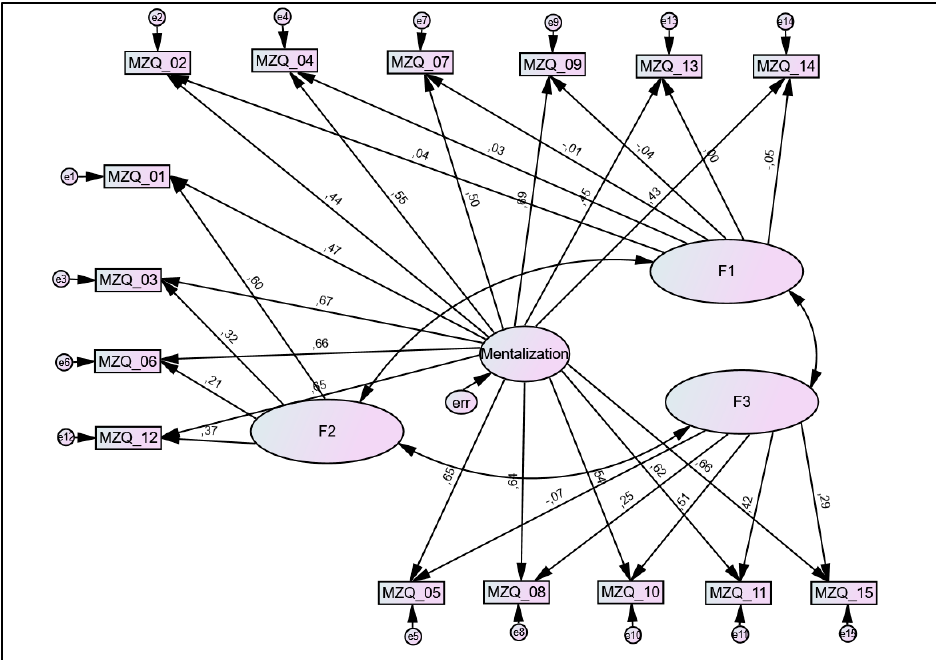
Figure 3. Bi-factor model for the Mentalization Questionnaire (MZQ) with a general factor and three subscales. Large circles represent proposed factors, rectangles represent items (with corresponding item number), and small circles represent error terms (e). Numbers next to arrows in the model represent standardized estimates. F1 = factor 1 (‘mental states in oneself regarding others—cognition and communication’; F2 = factor 2 (‘mental states regarding oneself—affect-regulation’); F3 = factor 3 (‘mental states regarding oneself—affect-perception and -differentiation’). Table 3. Correlations of MZQ-10 and MZQ-15 total score with OPD-SQS total score and subscales.